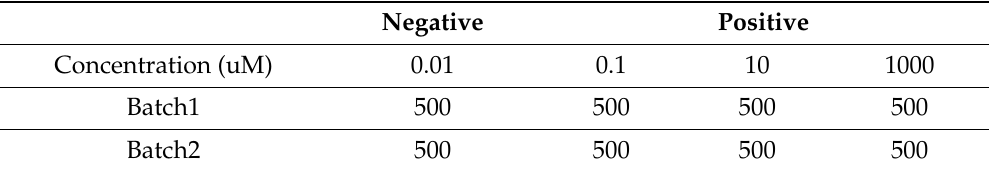
Figure 1. Configuration of the study. ( A ) Experimental setup of the proposed surface-enhanced Ra- man spectroscopy-based Pb(NO 3 ) 2 molecule detection model. ( B ) Real image of sample preparation and acquisition steps. ( C ) The hypothetical decision boundary learned by the proposed Radial Basis Function Kernel Support Vector Machine (RBFSVM) model. Table 1. Sample statistics of Pb(NO 3 ) 2